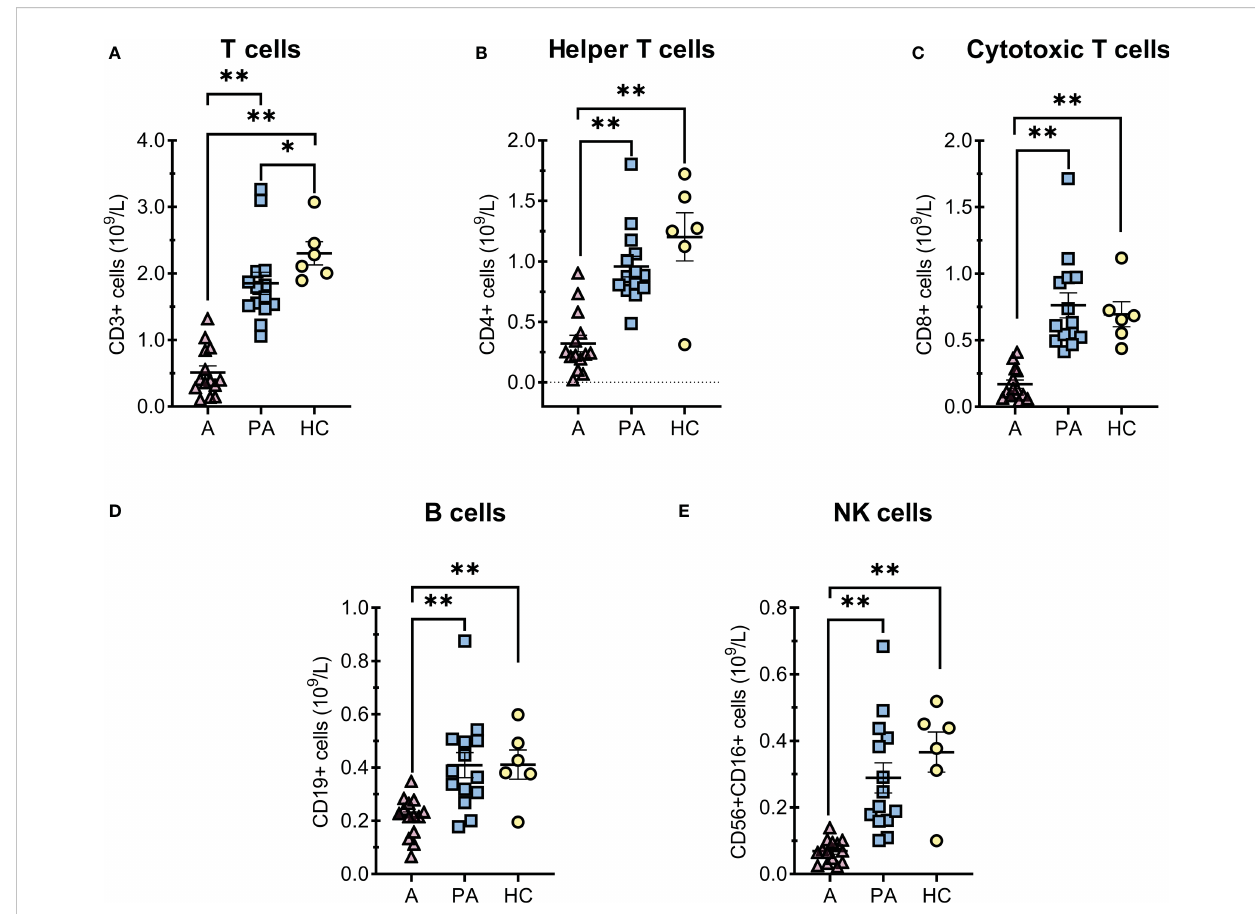
FIGURE 1 T and B cells alterations in MIS-C patients in the acute (A) and convalescent (post-acute) phase (PA) compared with age-matched healthy controls (HC). A-E, concentrations of (A) total T cells, (B) CD4+ helper T cells, (C) CD8+ cytotoxic T cells, (D) total B cells and (E) NK cells × 10 9 per liter of blood. Individual value plots show a point for the actual value of each observation in a group. Pink triangles represent patients with acute MIS-C (A, n = 14), blue squares represent patients with convalescent MIS-C (PA, n = 14), and yellow dots represent healthy controls (HC, n = 6). Data